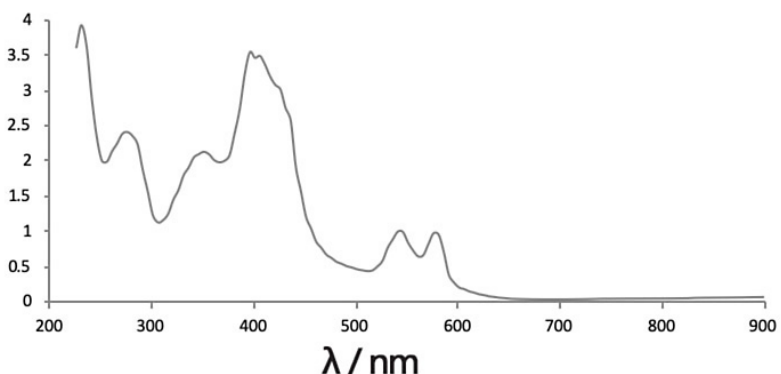
Figure 1. Scanning diagram of the total wavelength for donkey hemoglobin.